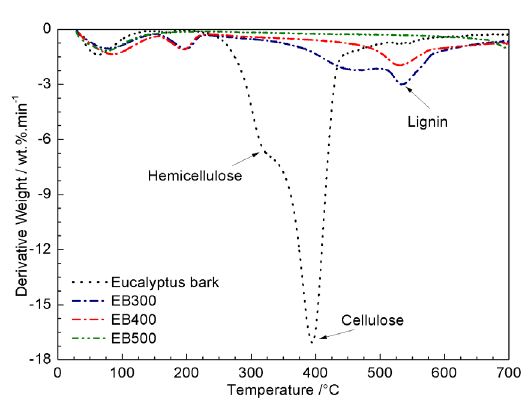
Figure 3. DTG curves for eucalyptus bark and charcoal produced.